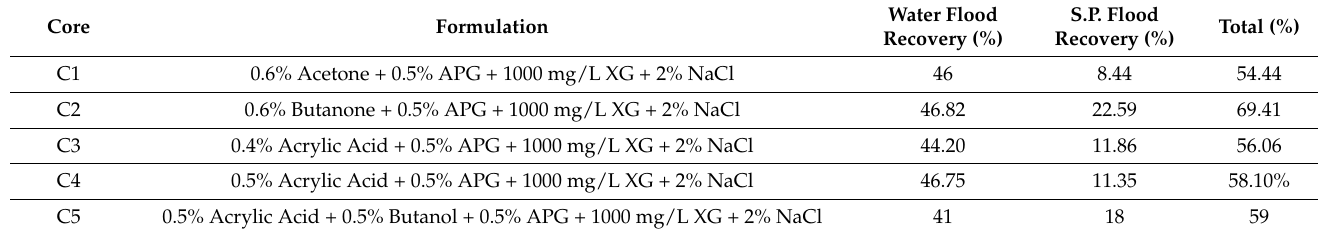
Table 10. Summary flood results of the five formulations.